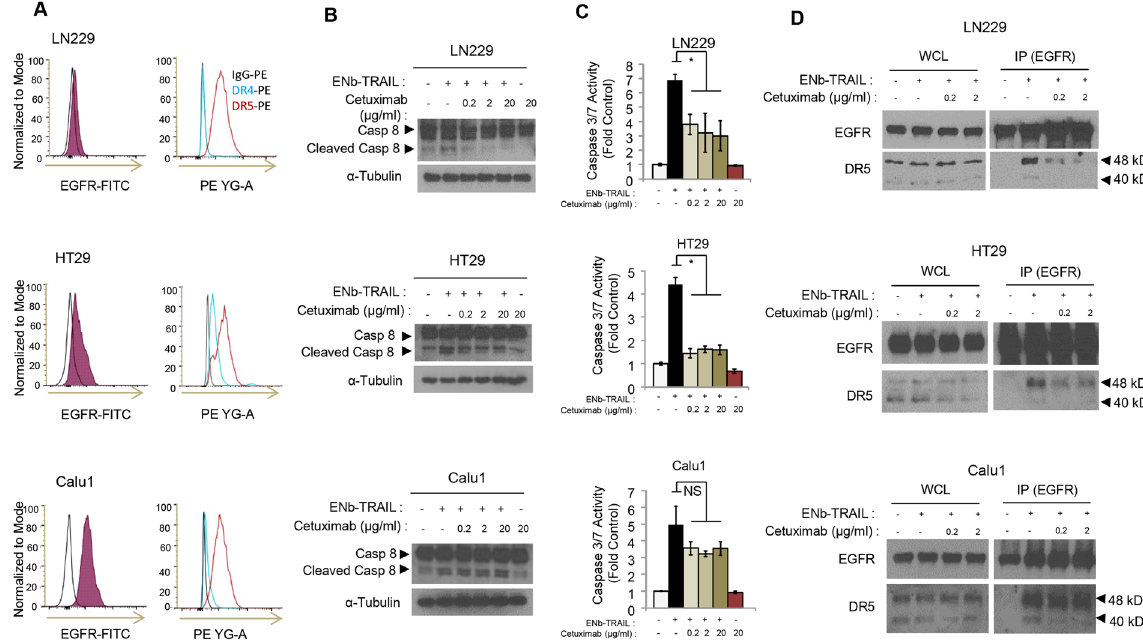
Figure 2. ENb-binding to EGFR is critical for ENb-TRAIL activation of apoptosis. ( A ) Differential cell membrane EGFR, DR4, and DR5 expression levels in LN229, HT29 and Calu1 cells measured by Flow Cytometry. Left panel: cell membrane EGFR expression. Right panel: cell membrane DR4 and DR5 expression. ( B–C ) Cells were pretreated with Cetuximab for 30 min and then treated with ENb-TRAIL for 8 h and apoptosis markers were analyzed by Western blotting ( B ) and caspase 3/7 assay ( C ). * P < 0.05 determined by unpaired t test. Error bars indicate SD. ( D ) Co-immunoprecipitation and Western blot analysis showing EGFR and DR5 complex formation in the presence of ENb-TRAIL and the attenuation of complex by Cetuximab. Western blots were cropped to show specific bands only. For uncropped blots see Fig.